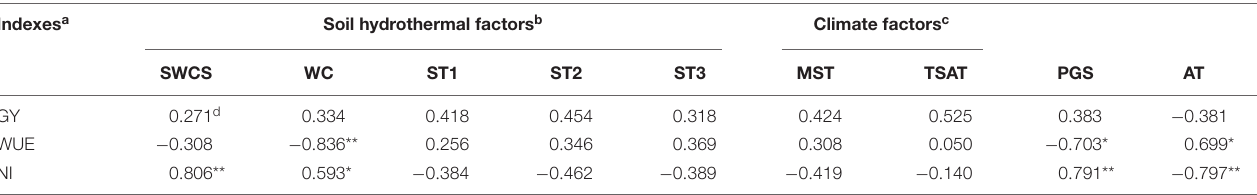
TABLE 6 | Correlation analysis between the grain yield, water use efficiency, net income, and soil hydrothermal and climate factors. Indexes a Soil hydrothermal factors b Climate factors